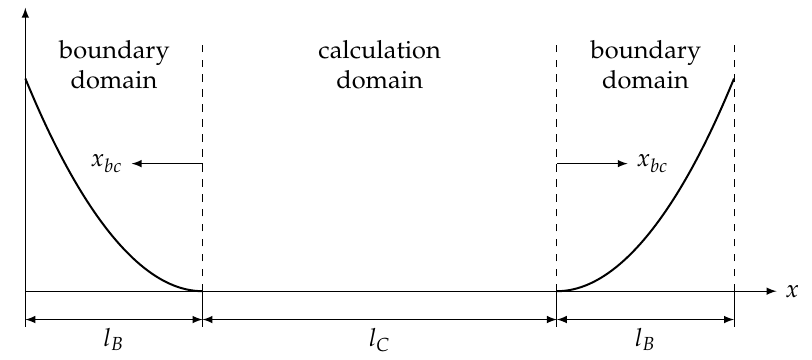
Figure 5. Boundary domains and the local coordinate